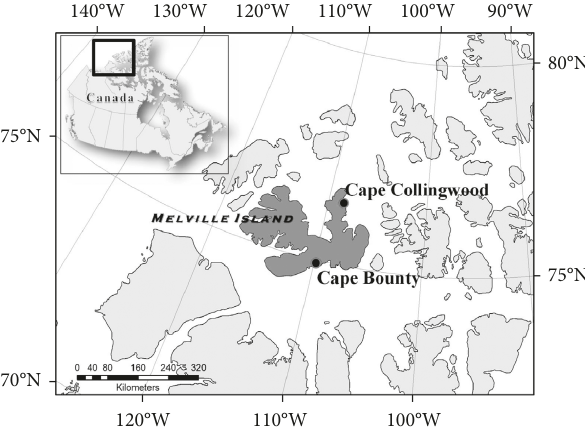
Figure 1: Study area location in the Canadian High